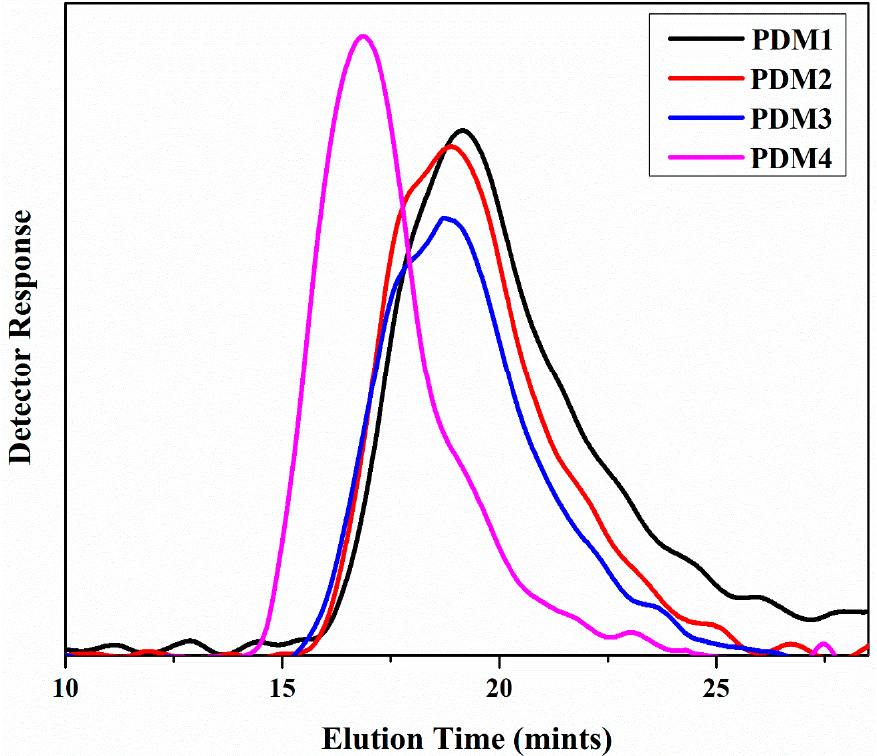
Figure 6. Gel Permeation Chromatography (GPC) analysis of ( a ) PDM1, ( b ) PDM2, ( c ) PDM3 and ( d ) PDM4.